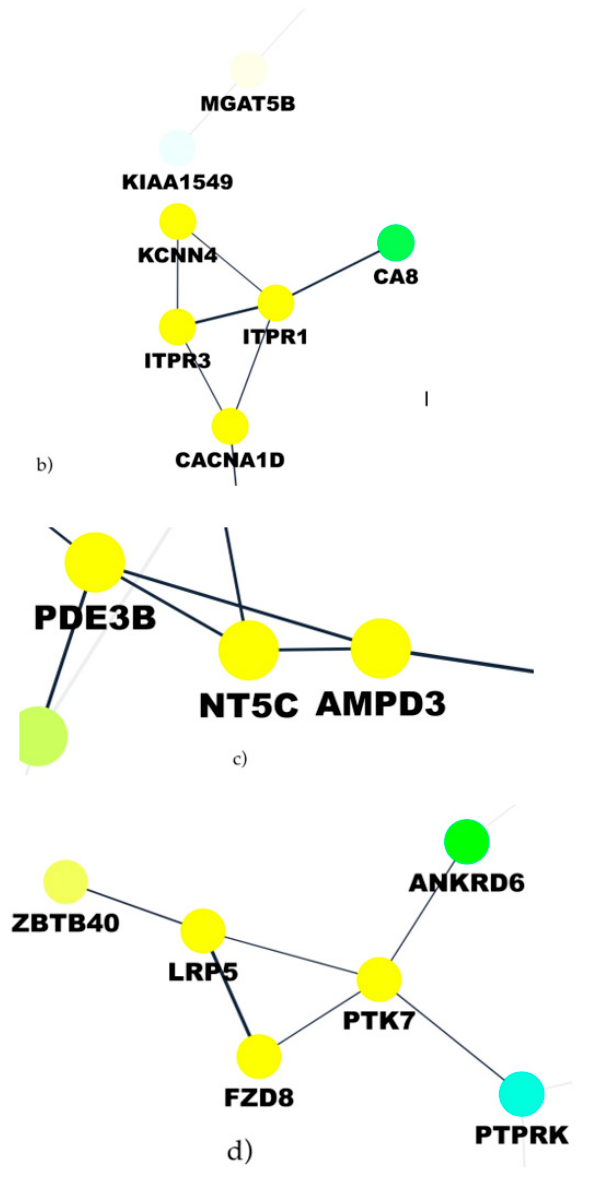
Figure 5. ( a ) Protein–protein interaction (PPI) network derived from the co-expression network. ( b – d ) Subnetworks identified by the Molecular Complex Detection (MCODE) algorithm. Table 3. Functional enrichment of the first subcluster of the protein–protein interaction (PPI) network.